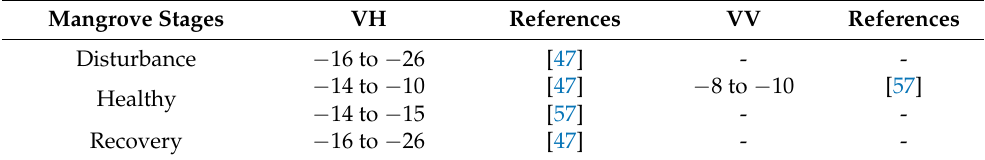
Table 3. The Values of VH and VV backscatter for Discrimination of Mangrove Stages/Previous Studies. Mangrove